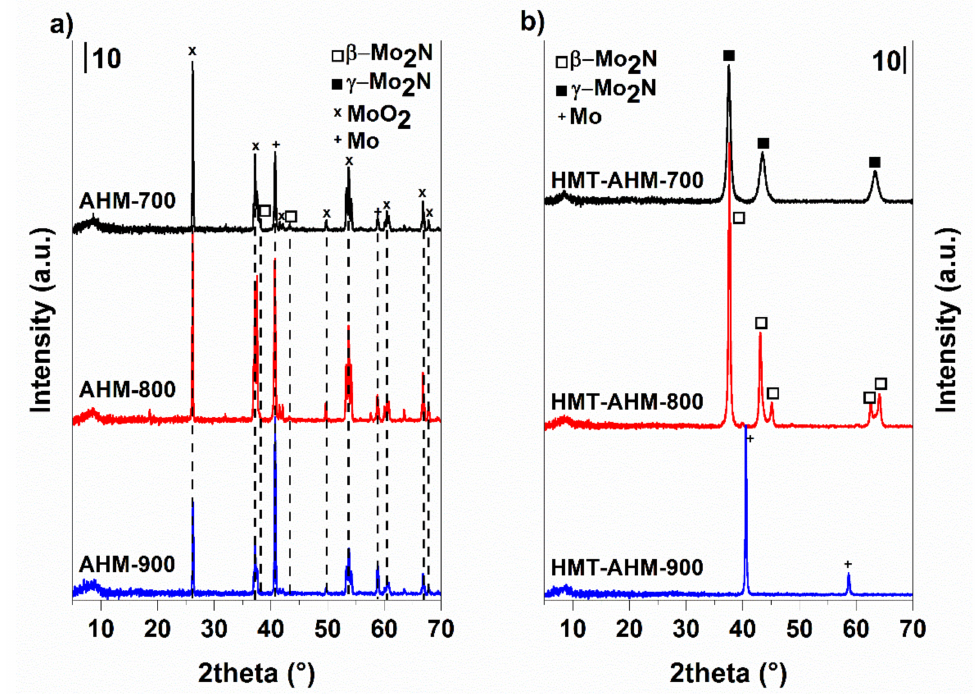
Figure 10. X-ray diffraction patterns of the molybdenum nitrides prepared from AHM ( a ) and HMT-AHM ( b ) at 700–900 ◦ C.